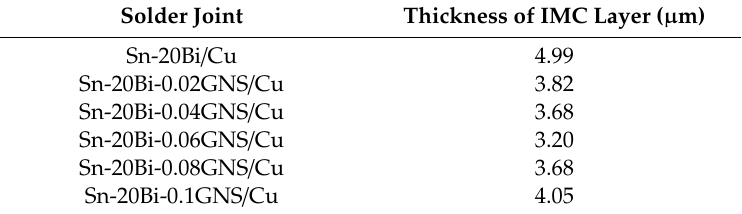
Table 3. Thickness of intermetallic compound (IMC) layer at Sn-20Bi-xGNS / Cu solder joint.